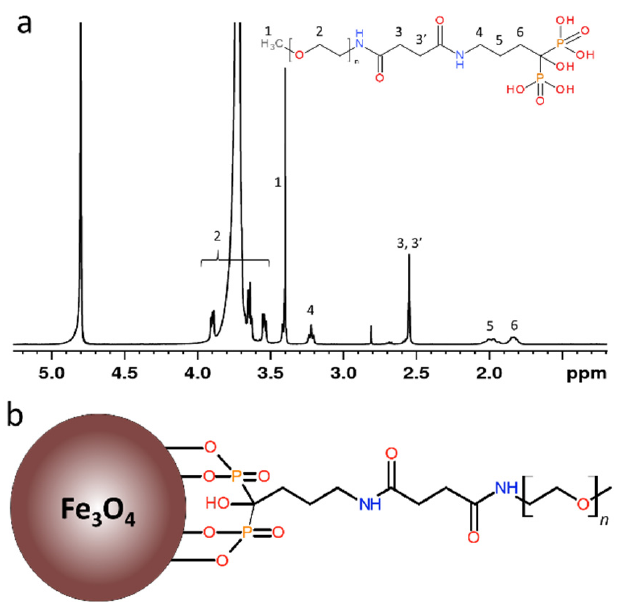
Figure 1. ( a ) 1 H NMR spectrum of PEG-Ale and ( b ) scheme of Fe 3 O 4 @PEG-Ale nanoparticles. PEG-Ale, poly(ethylene glycol)-alendronate.